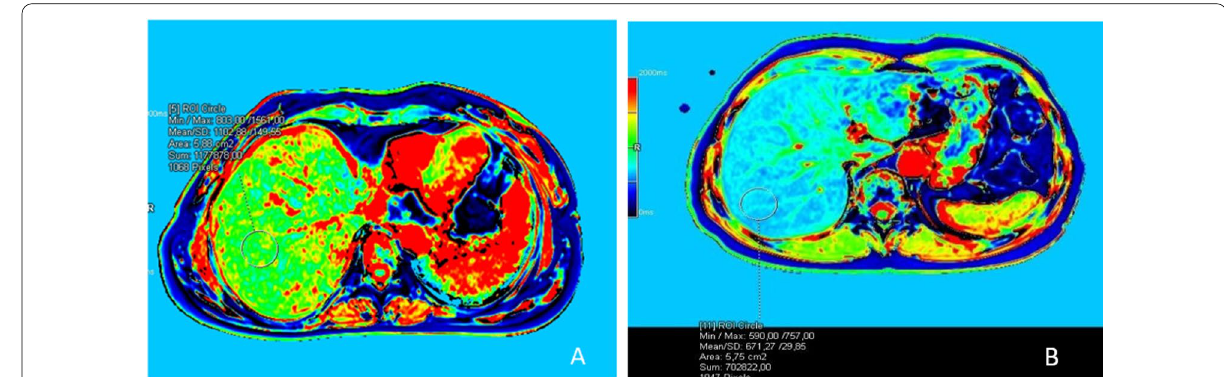
Fig. 4 T1 mapping images demonstrates a T1 relaxation time of 1102 ms in a patient with SOS ( A ) and 671 ms in a control patient ( B )